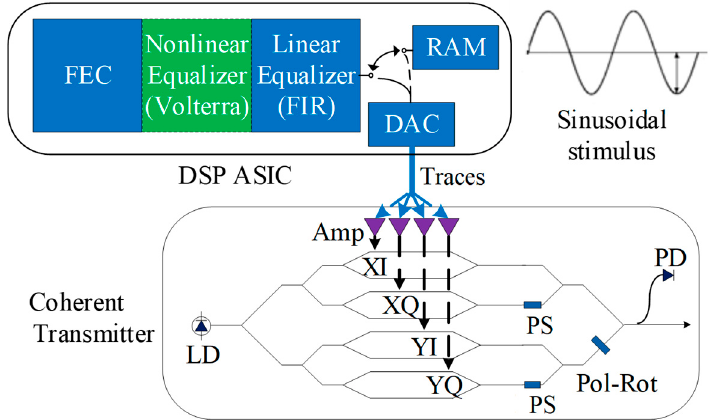
Figure 1. The block diagram of the coherent IQ transmitter and the DSP ASIC. PS: phase shifter, Pol-Rot: polarization rotator. DAC input can be switched between RAM and regular path.